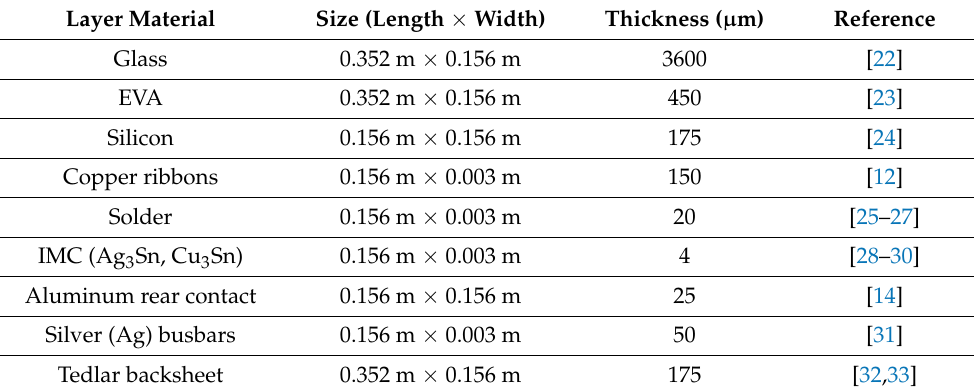
Table 3. The geometric properties of layer materials in solar PV cell.